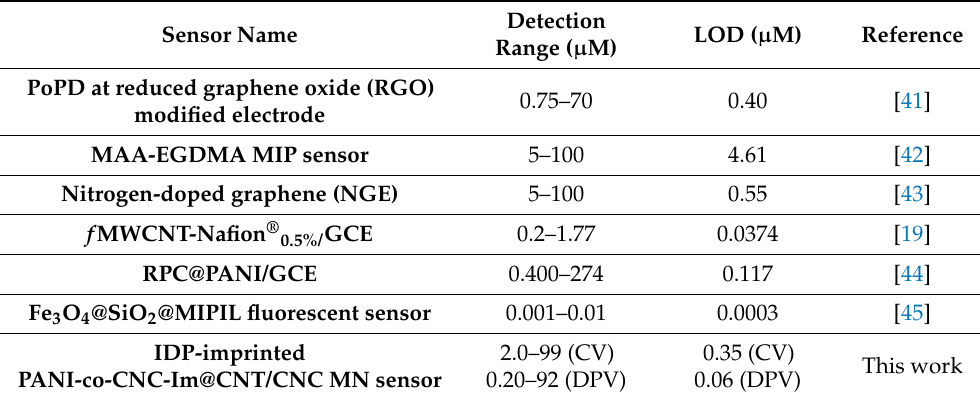
Table 4. Literature comparison of imidacloprid (IDP) sensor performance metrics to the